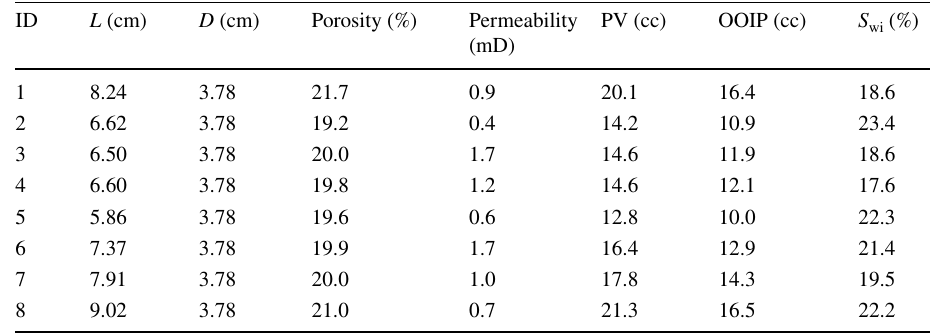
Table 1 Tests and core